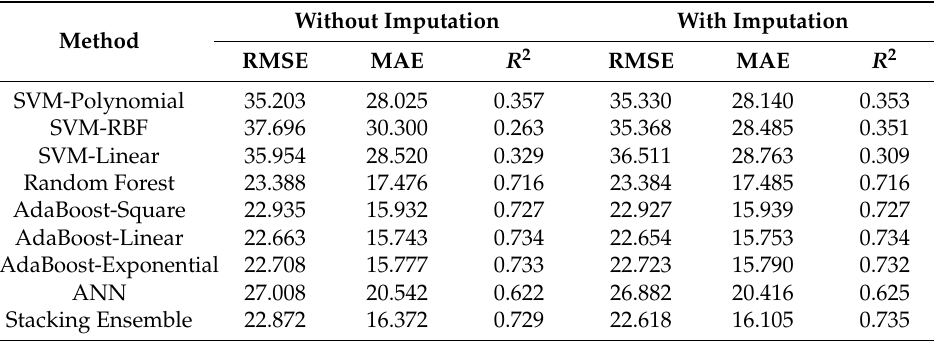
Table 12. Results of ML Algorithms for Fengshan F24-AQI Prediction.